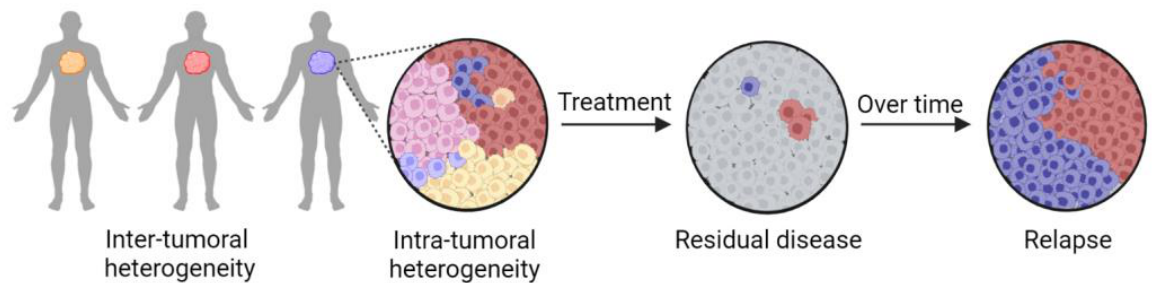
Figure 1. Heterogeneity in cancer takes place at multiple levels and affects patient outcomes. Inter-tumoral heterogeneity is the genetic and non-genetic differences (represented by different colors) between the same type of tumors in different patients and contributes to how patients will respond to therapy. Inter-tumoral heterogeneity is the basis for precision medicine approaches. Intra-tumoral heterogeneity is genetic and functional differences between populations or sub-clones of a single tumor (shown by different colors), identified by next-generation sequencing approaches. Following treatment of a heterogonous tumor, some sub-clones may be inherently drug-resistant or acquire alterations to provide a survival advantage, potentially resulting in patient relapse.